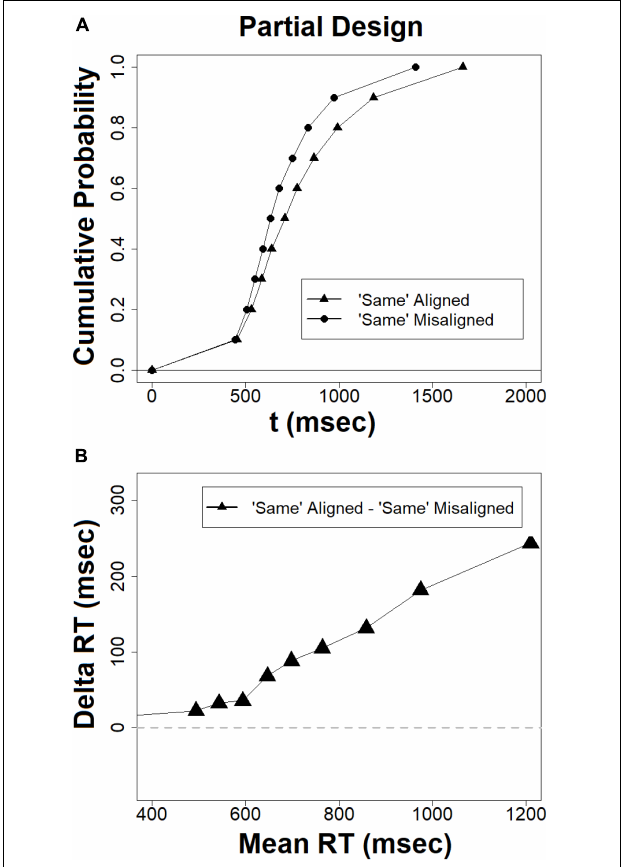
FIGURE 7 | (A) Cumulative probability functions (CDFs) for the partial design, (B) delta plots for the partial design, the abscissa = (mean RT congruent + mean RT incongruent)/2.